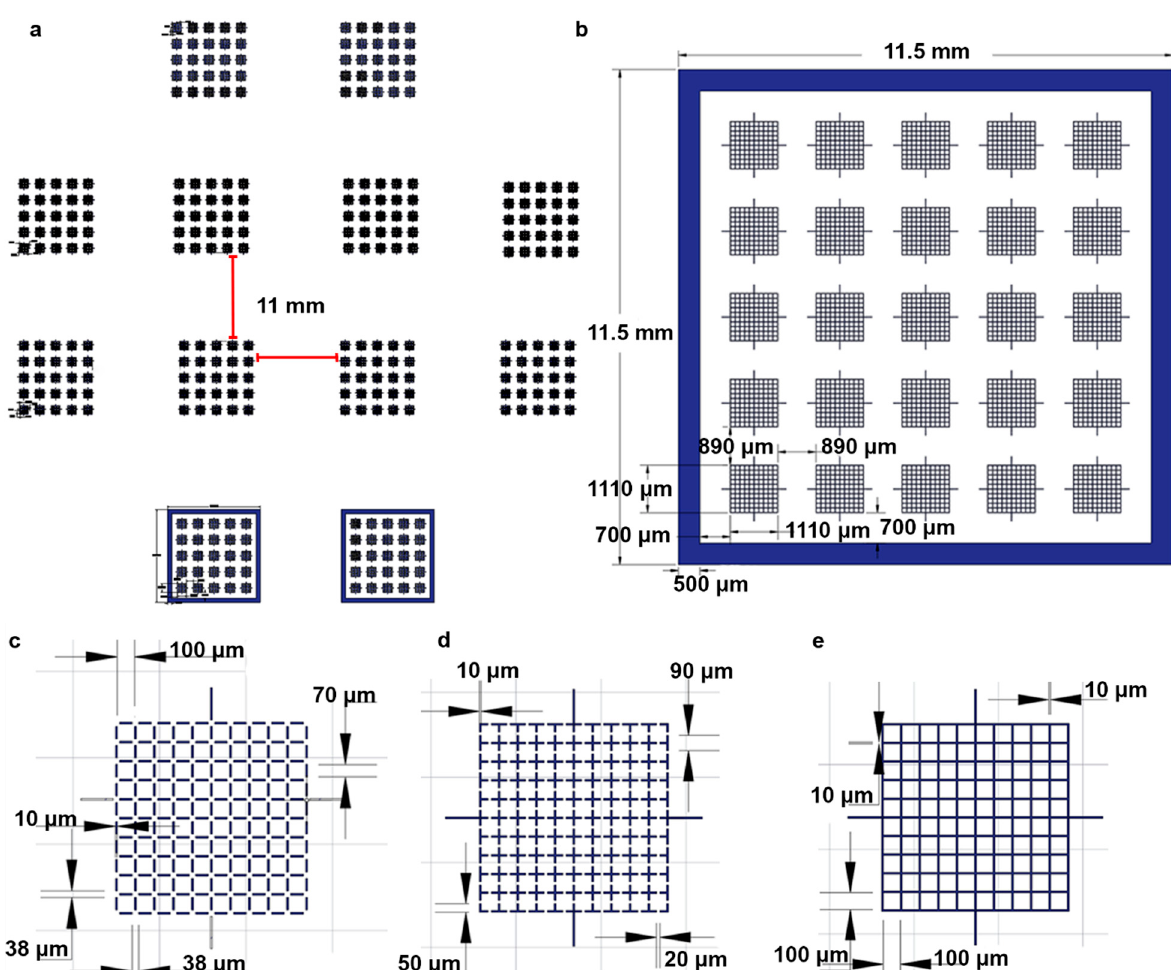
Figure 1. Renderings of the 2-dimensional design of SSCC device. Overall design used to create the photomask for fabrication of the SSCC chips ( a ). Each device contained 25 arrays in a 5 × 5 pattern ( a , b ), with the enclosed design incorporating a border surrounding the grids ( b ). Each grid contained 100 squares arranged in a 10 × 10 pattern ( c – e ) with each square measuring 100 µm (L) × 100 µm (W) × 10 µm (H). Three different grid designs were produced: open-corners ( c ), open-midpoint ( d ), and closed-grids ( e ). Only the closed-grid design incorporated enclosed walls surrounding the array ( b ).